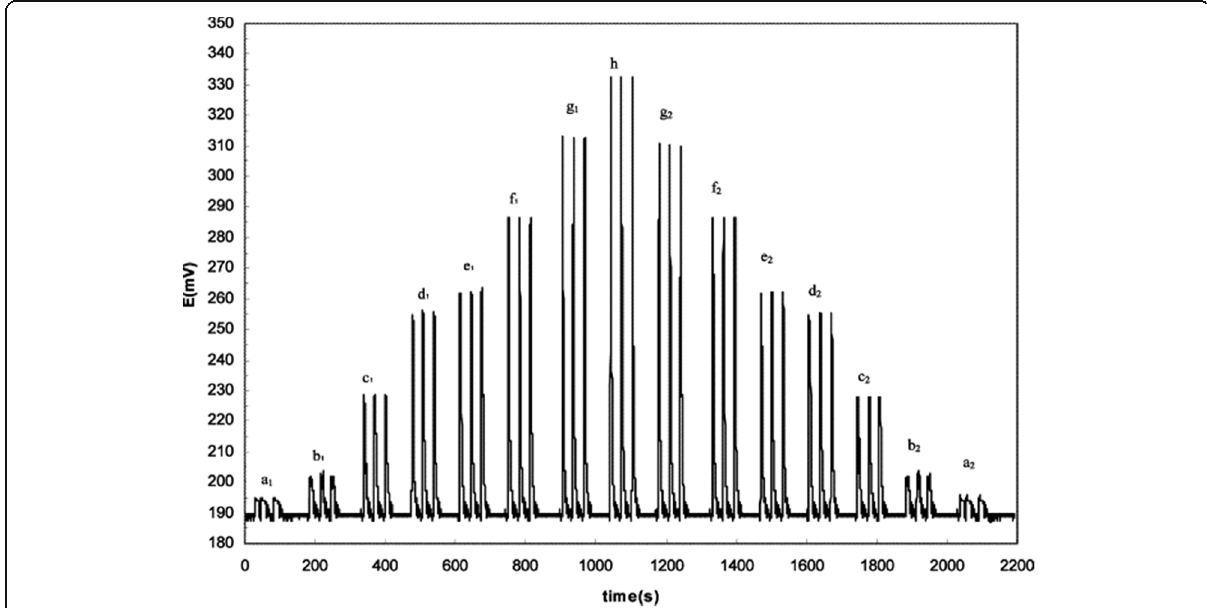
Fig. 3 Potentiometric peaks for three repetitive measurements of different Pb 2+ ion concentrations. (Reprinted with permission from Reference Karami et al. 2003). © 2003